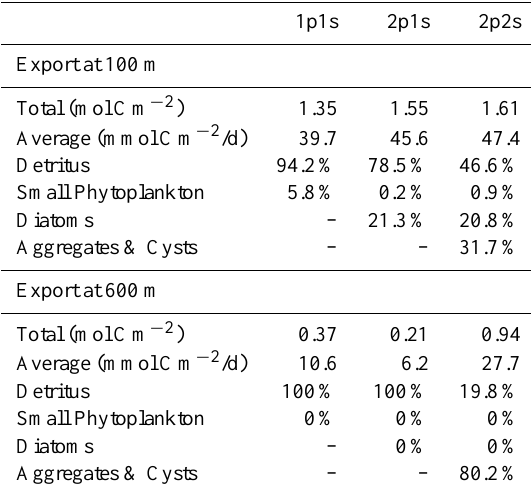
Fig. 10. Simulated carbon export at 100 and 600m depth. Table 5. Simulated POC export at 100 and 600m (total export in- tegrated over the simulation period and average flux) and contribu- tions of each